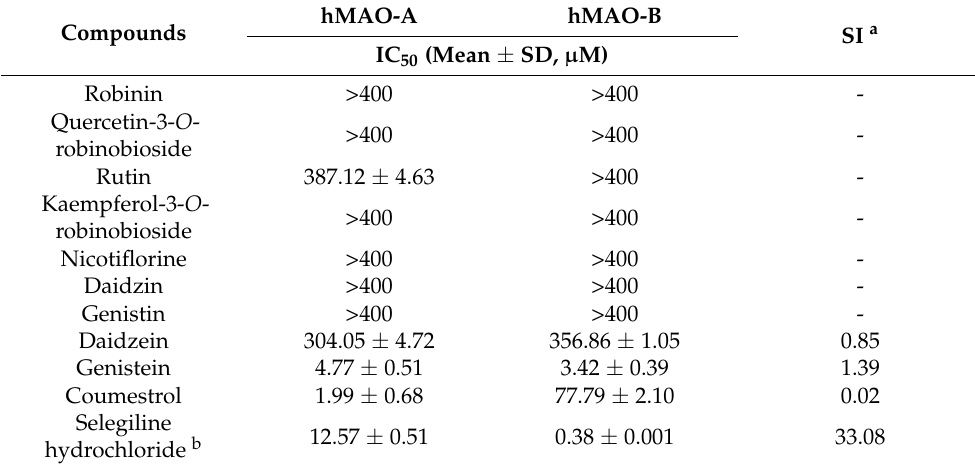
Table 2. Inhibitory activity of the major constituents of PL-L-70E against hMAOs.